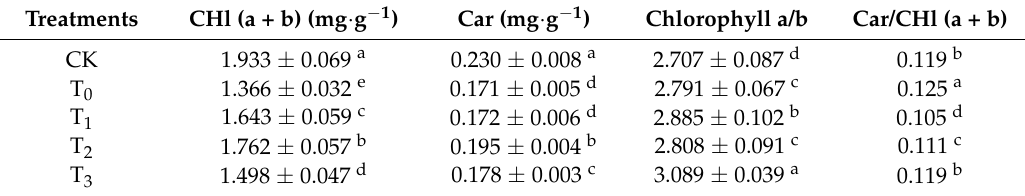
Table 3. Effect of the NO donor on pigment concentrations under enhanced UV-B radiation in Larix gmelinii